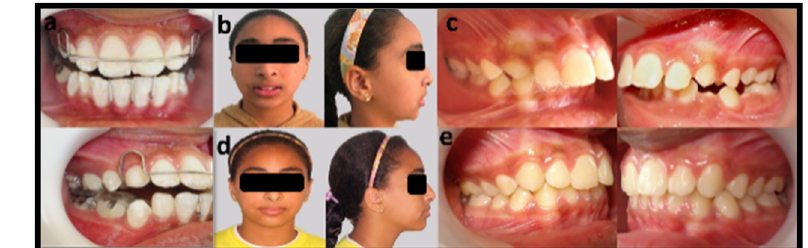
Figure 4. Photographs showing twin block appliance group: ( a ) intra oral frontal and lateral views of the appliance inside the patient’s mouth; ( b ) preoperative frontal and lateral extraoral views, showing a convex facial profile and incompetent lip seal; ( c ) preoperative right / left lateral intraoral view, showing class II canine and molar relation; ( d ) postoperative frontal and lateral extraoral views, showing a competent lip seal and straight facial profile; ( e ) postoperative right / left lateral intraoral views, showing class I canine and molar relation and reduced overjet.